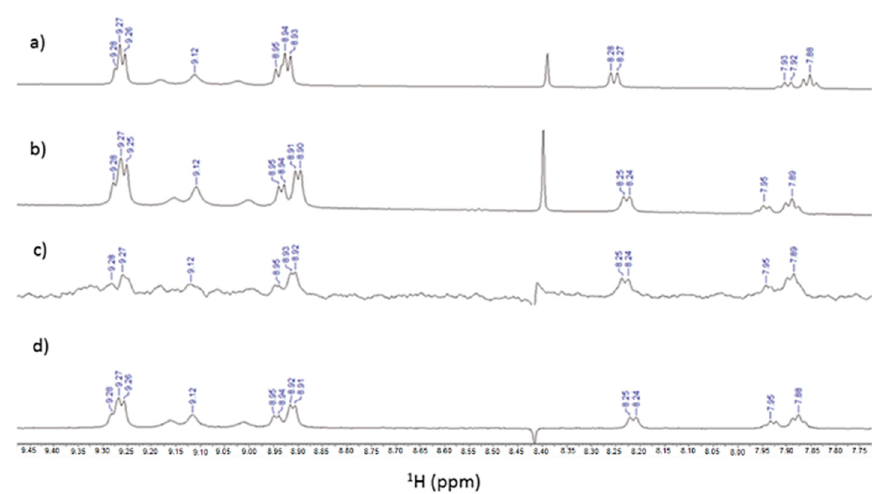
Figure 6. ( a ) Low ‐ field of 1 H NMR spectrum of Tris ‐ T4 (175 μ M) in the buffer (50 mM Hepes, 100 mM NaCl and 1mM DTT); ( b ) in the presence of a 20S proteasome (860 nM); ( c ) STD and ( d ) WaterLOGSY spectra.